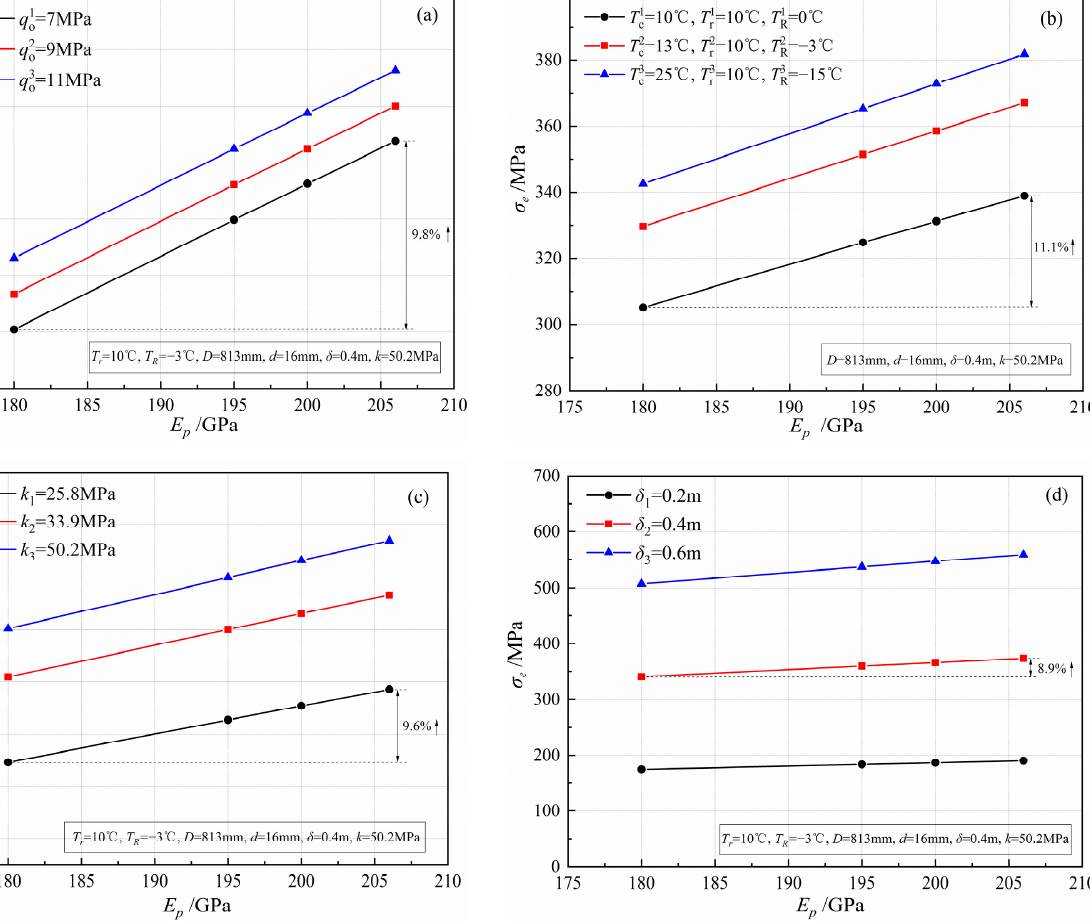
Figure 13. Variations in the equivalent stress with respect to the pipe’s elasticity modulus. ( a ) Under different oil pressures; ( b ) under different temperature differences; ( c ) under different foundation coefficients; ( d ) under different frost heaves.